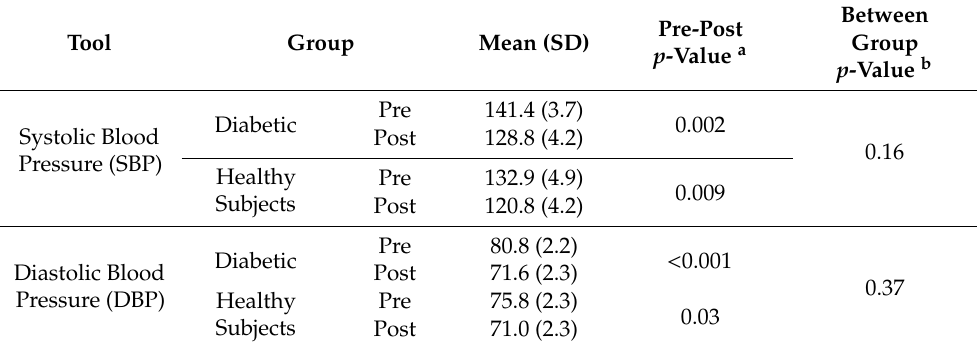
Table 4. Mean (SD) of systolic and diastolic blood pressure at pre- and post-intervention over the time in diabetic ( n = 12) and healthy subjects ( n =